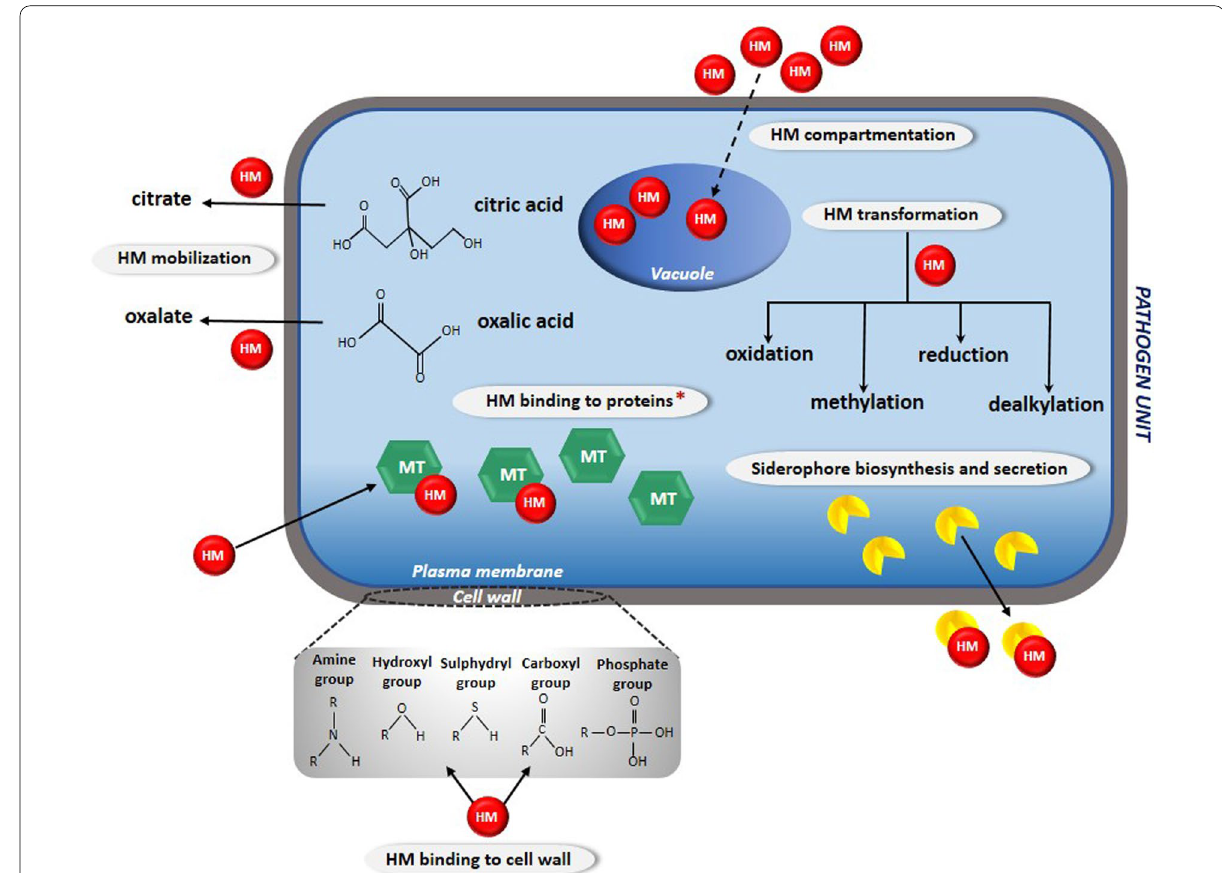
Fig. 1 The potential mechanisms of HMs detoxification operating in fungal and fungal‑like pathogens. HM heavy metal; MT metallothioneins; Red asterisk indicates the mechanism documented also in